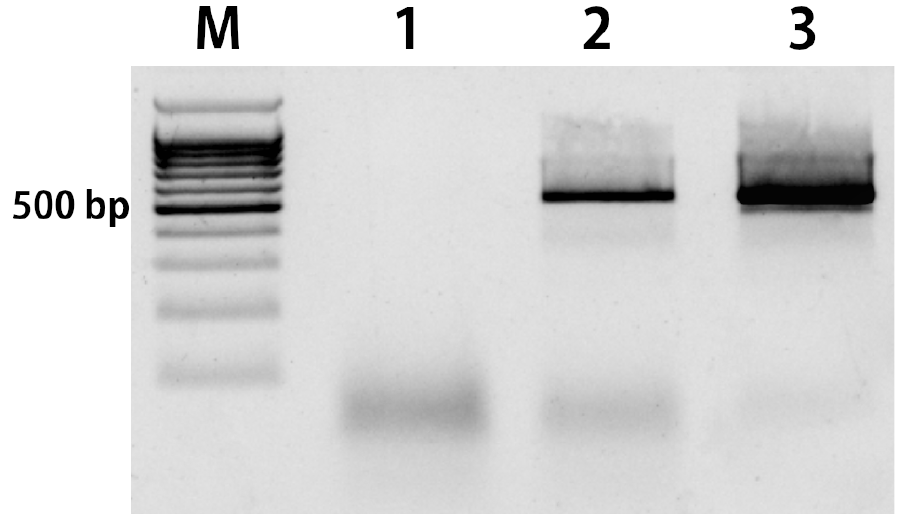
Figure 1. PCR amplification of the gene encoding LFS in onion: M—DNA Ladder 100bp+; lane 1—mature pollen without washing; lane 2—mature pollen after 10-times washing in ddH 2 O; lane 3—genomic DNA of A. cepa